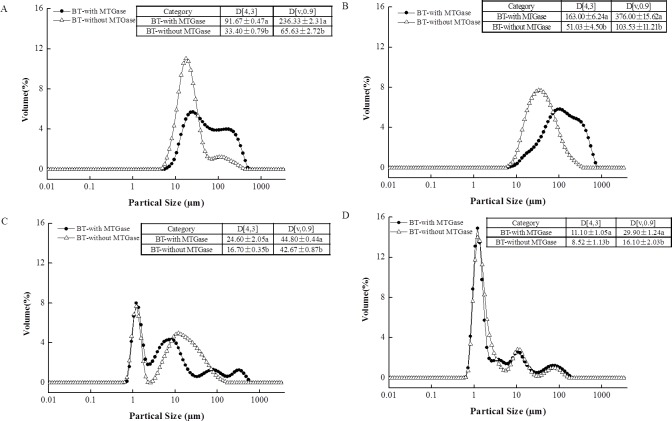
Particle size distribution of the mixed soy-cow protein samples (A) before the GIS digestion, (B) after buccal digestion, (C) after gastric digestion, (D) after intestinal digestion. Different patterns represented bio-tofu with MTGase (BT-with MTGase –●–), and bio-tofu without MTGase (BT-without MTGase –Δ–). Data are expressed as mean ± SD from triplicate experiments. Different letters within the same column indicate significant difference (P < 0.05).